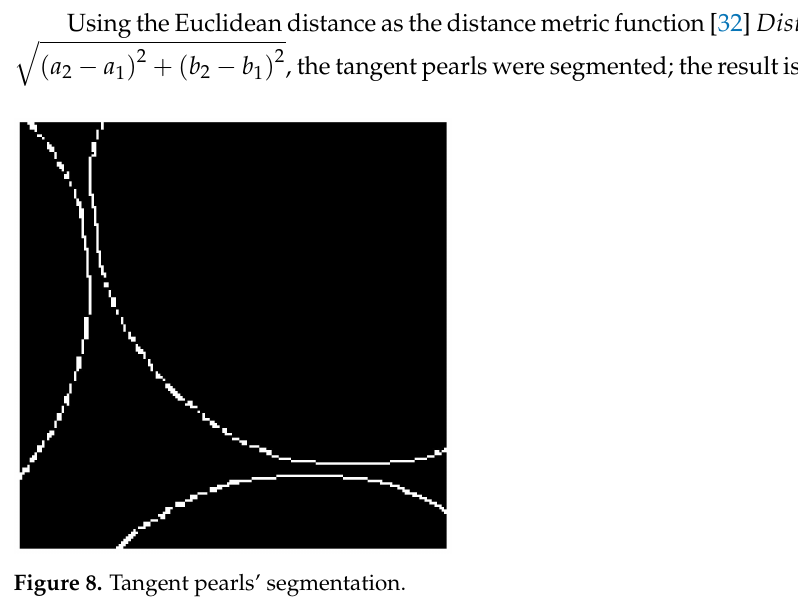
Figure 7. Preliminary pit detection.